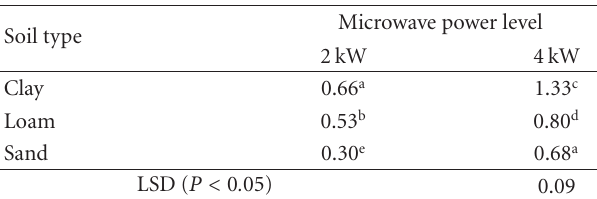
Table 3: Average heating rate for air dry soil samples ( ◦ C per second).